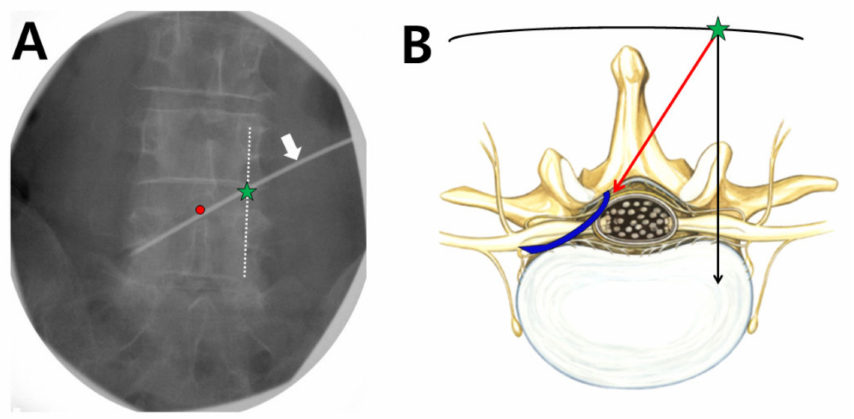
Figure 2. Determining the entry point and catheter pathway on the fluoroscopic anteroposterior view. ( A ) A simulated surface marker (white arrow) positioned between the lower portion of the ipsilateral pedicle, where the corresponding symptomatic spinal nerve exits, and the interlaminar epidural opening site over the interspinous process (red dot). The entry point of the guide needle (green star) is the point at which the contralateral longitudinal pedicular lines (dotted line) and the simulated surface marker intersect. ( B ) Schematic cross-sectional drawing of the route of the guide needle and foraminal balloon catheter. The red arrow shows the direction of the needle from the needle entry point (green star); this must cross the midline to ipsilateral epidural space, otherwise the catheter may be advanced into the contralateral neural foramen. The blue line shows the insertion pathway of the foraminal balloon